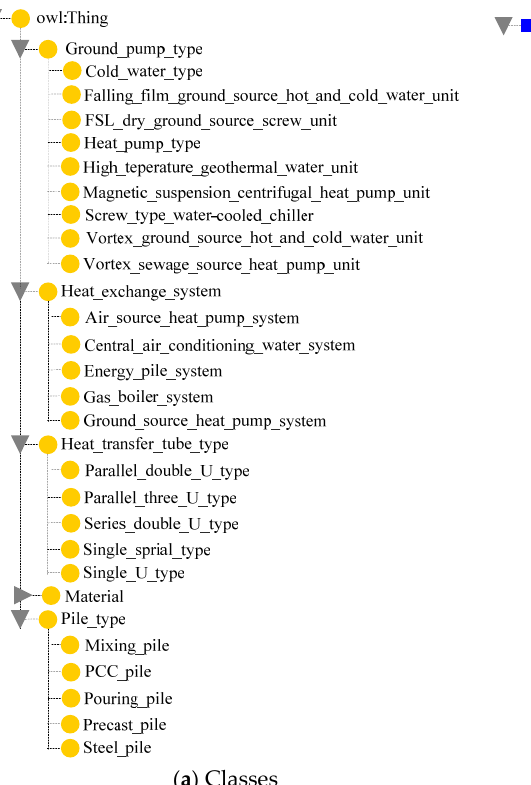
Figure 5. The developed ontology in the protégé-OWL 5.2.